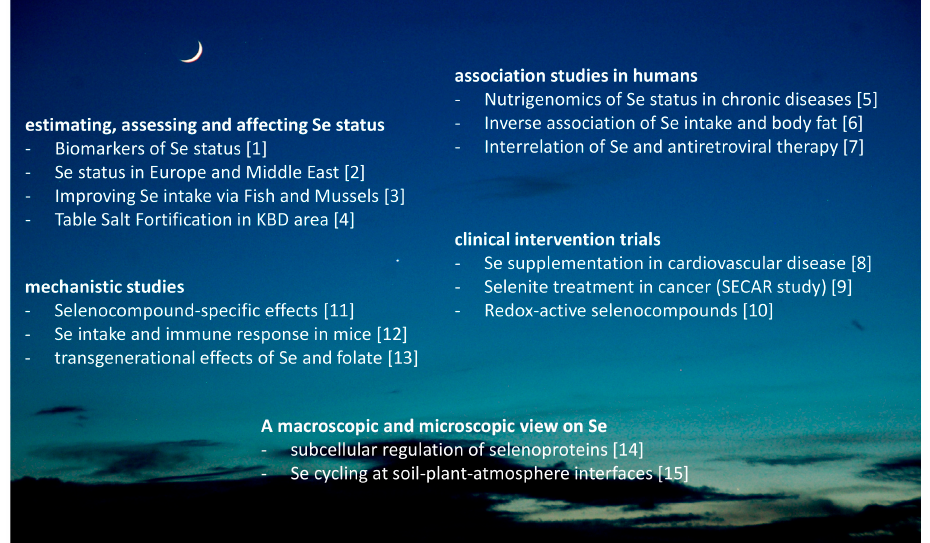
Figure 1. Overview on the Special Issue entitled “Dietary Selenium and Human Health”. The topics covered in the special issue range from the microscopic to a global perspective, from association to intervention studies in both humans and model systems, with the aim of providing an up-to-date insight into the various research fields that nowadays contribute to our understanding of this essential trace element 200 years after its identification. The numbers in brackets refer to the references. The photograph showing the moon and implying that our work is conducted under the